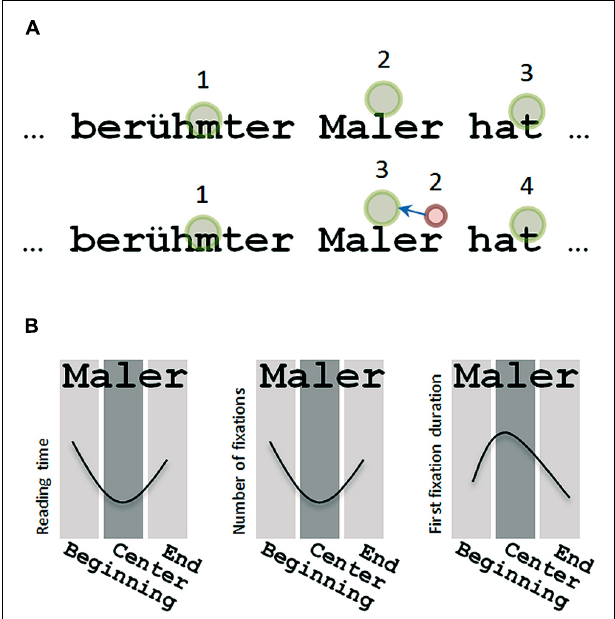
FIGURE 1 | (A) Schematic illustration of eye movements during reading. Standard reading fixations are presented as green circles and the numerals indicate the sequential order. In the lower line a corrective re-fixation occurs after suboptimal landing at the end of the word Maler. The initial fixation on Maler , presented in a smaller red circle (indicating a shorter fixation duration), is followed by a saccade (blue arrow) to set up a fixation near the word center (Hutzler etal., 2008). (B) The optimal viewing position effects (OVP effect) for reading times and the number of fixations for landing positions at the beginning, the center and the end of the word Maler .The right panel depicts the inverted optimal viewing position effect (I-OVP effect) for first fixation durations.The OVP effect shows longer reading times and a higher number of fixations after landing at the word beginning or the word end. In contrast, the I-OVP effect on first fixation durations shows the shortest fixation durations at word beginnings or ends and the longest durations at the word center. Note that, after landing at the word center of a short to medium length word (e.g., smaller than eight letters) only one fixation is typically required for word recognition (e.g.,Vitu etal.,